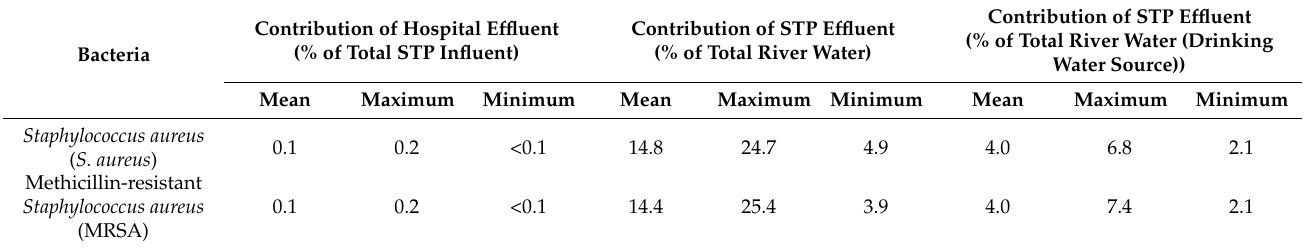
Table 3. Contributions of Staphylococcus aureus ( S. aureus ) and methicillin-resistant Staphylococcus aureus (MRSA) in each type of water sample.